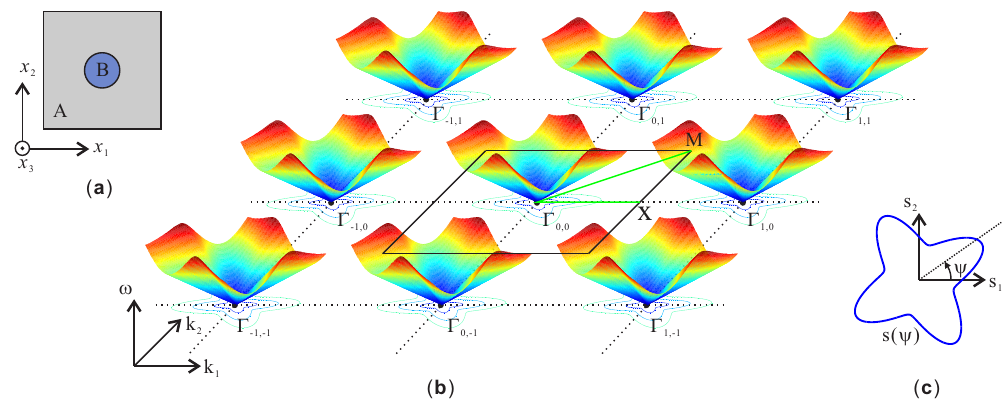
Figure 1. Graphical construction of the empty lattice model for anisotropic phononic crystals. ( a ) The unit cell of a two-dimensional square-lattice phononic crystal. When the matrix (A) and the inclusion (B) are composed of the same material, the model reduces to the unit cell of the empty lattice. ( b ) The dispersion relation for Bloch harmonics in reciprocal space is a set of cones originating from reciprocal lattice points. The vertical axis is the angular frequency. The horizontal plane is the reciprocal space, and the black dots are for reciprocal lattice points labeled as Γ α with α 1 and α 2 being arbitrary 1 , α 2 integers. The central square centered at Γ 0,0 (black solid line) is the boundary of the first BZ for the square lattice with high symmetry points X and M. The colored lines centered around each reciprocal lattice points represent the isofrequency curves of an arbitrary anisotropic material. The shape of isofrequency curves is a frequency-scaled version of the slowness curve for the considered bulk wave shown in ( c ). ψ is the direction angle defined with respect to the s 1